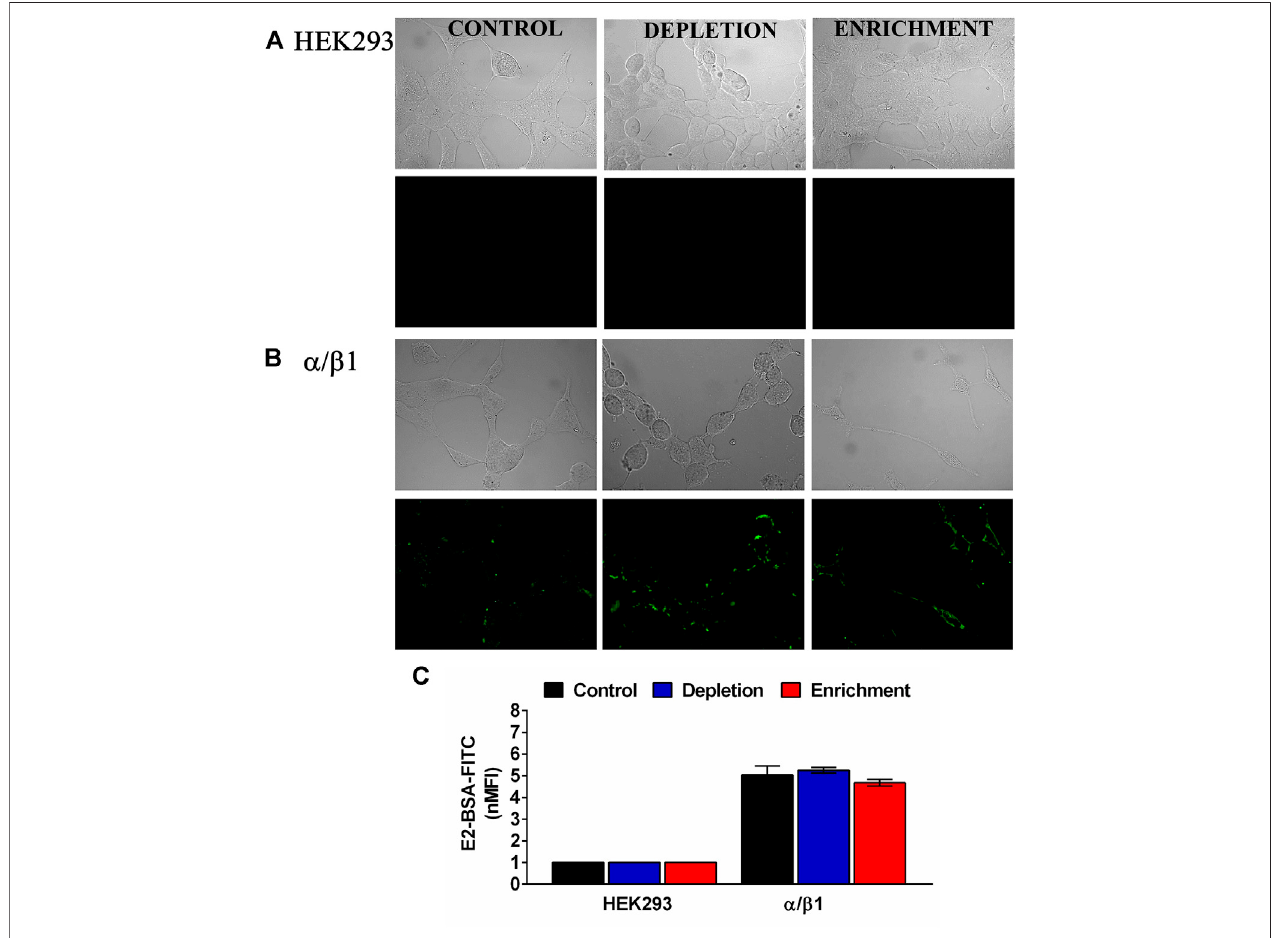
FIGURE 3 | Membrane cholesterol content does not modify E2 binding to the BK channels subunits in HEK293 cells. (A) HEK293 cells without transfection. (B) α / β 1 subunit co- transfection. (C) Quanti fi cation by fl ow cytometry of E2-BSA-FITC binding to the BK channel transfected cells. Data were normalized against HEK293 cellswithouttransfection.Depletedcells(bluebars). α / β 1:5.2 ± 0.13.Enrichedcells(redbars). α / β 1:4.7 ± 0.2;blackbarsrepresentcontroluntreatedcells. α / β 1:5.0 ± 0.4. Error bars: SEM. n (cid:2)